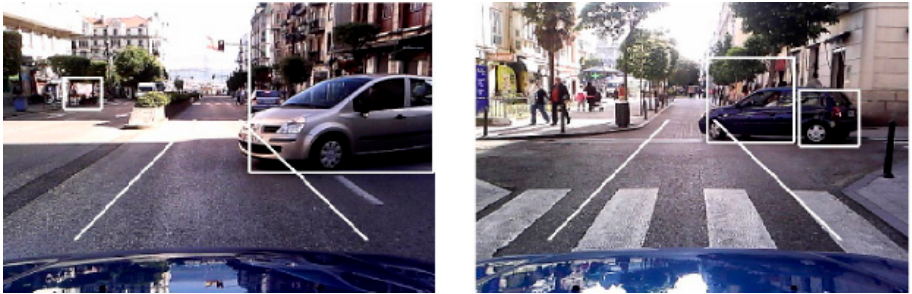
Figure 7. Hypotheses generated by vehicles travelling transversely on crossroads.